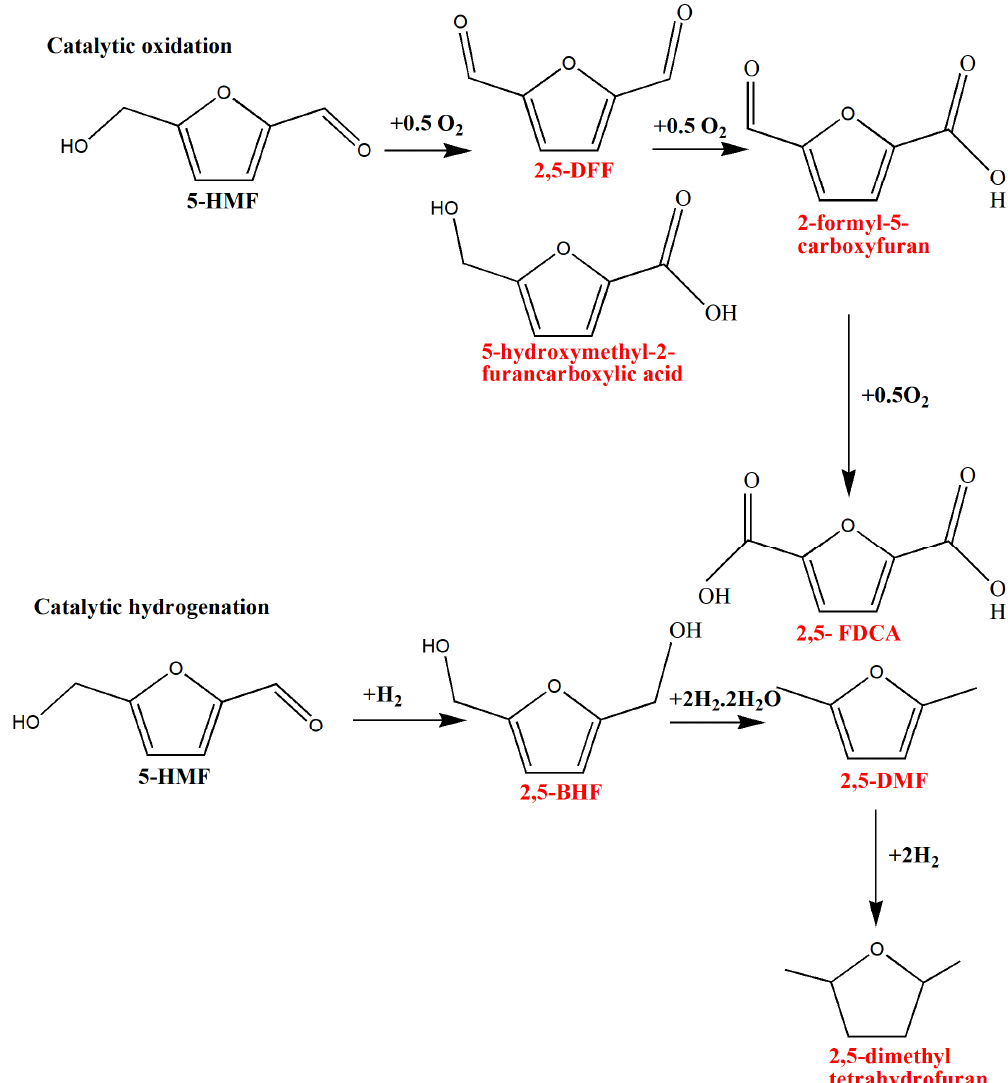
Figure 8. Catalytic oxidation and hydrogenation routes of 5-HMF [2,5-DFF: 2,5-diformylfuran; 2,5-BHF: 2,5-bis(hydroxymethyl)furan; 2,5-DMF: 2,5-dimethylfuran; and 2,5-FDCA: 2,5-furandicaroxylic acid] [86].